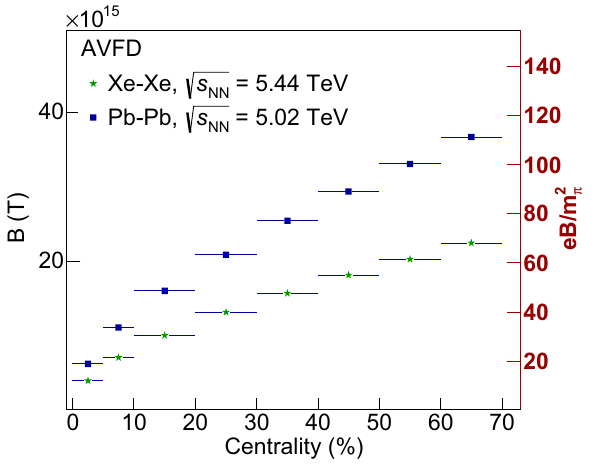
Fig. 1 The dependence of the average value of the magnetic field per- pendiculartothereactionplane( B y )oncentralityforPb–PbandXe–Xe √ √ s NN = 5 . 02 and s NN = 5 . 44 TeV, respectively collisions at